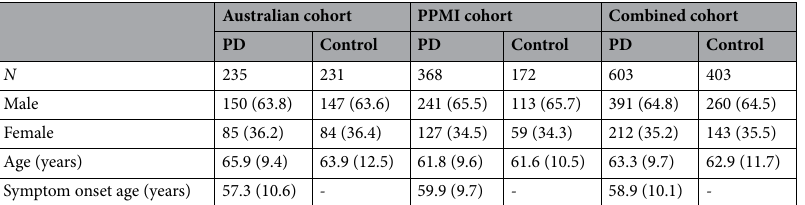
Table 1. Summary of the independent and combined cohort demographic information. Data presented as Mean (SD) or n (%). PPMI, Parkinson’s Progression Markers Initiative; PD, Parkinson’s